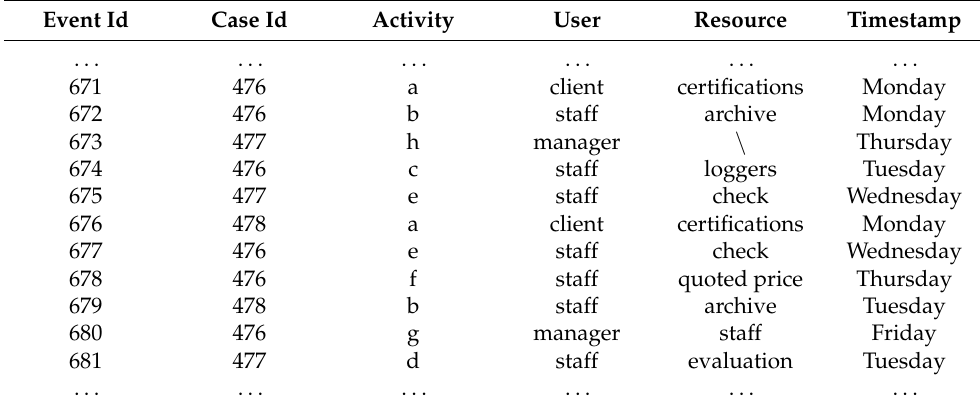
Table 1. Event log